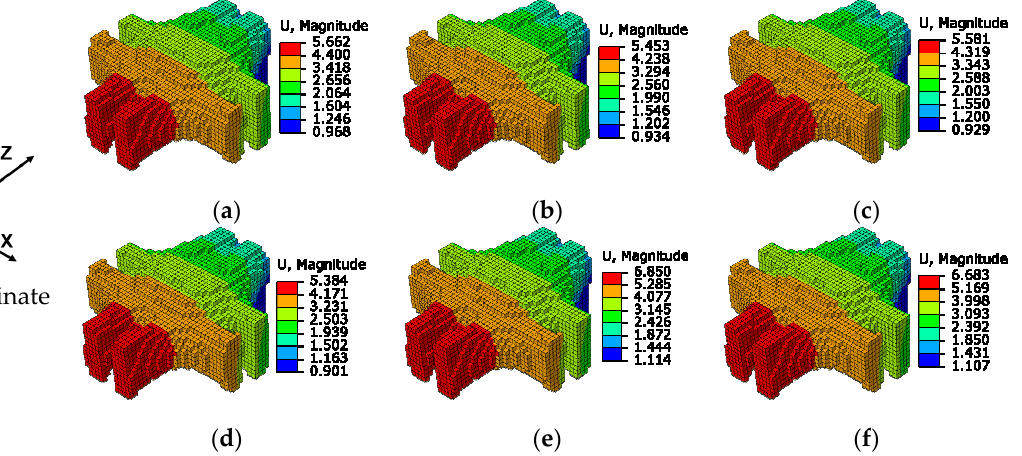
Figure 14 . Displacement nephogram under isotropic optimization: ( a ) X-direction print, Y-direction scan; ( b ) X-direction print, Z-direction scan; ( c ) Y-direction print, X-direction scan; ( d ) Y-direction print, Z-direction scan; ( e ) Z-direction print, X-direction scan; ( f ) Z-direction print, Y-direction scan .